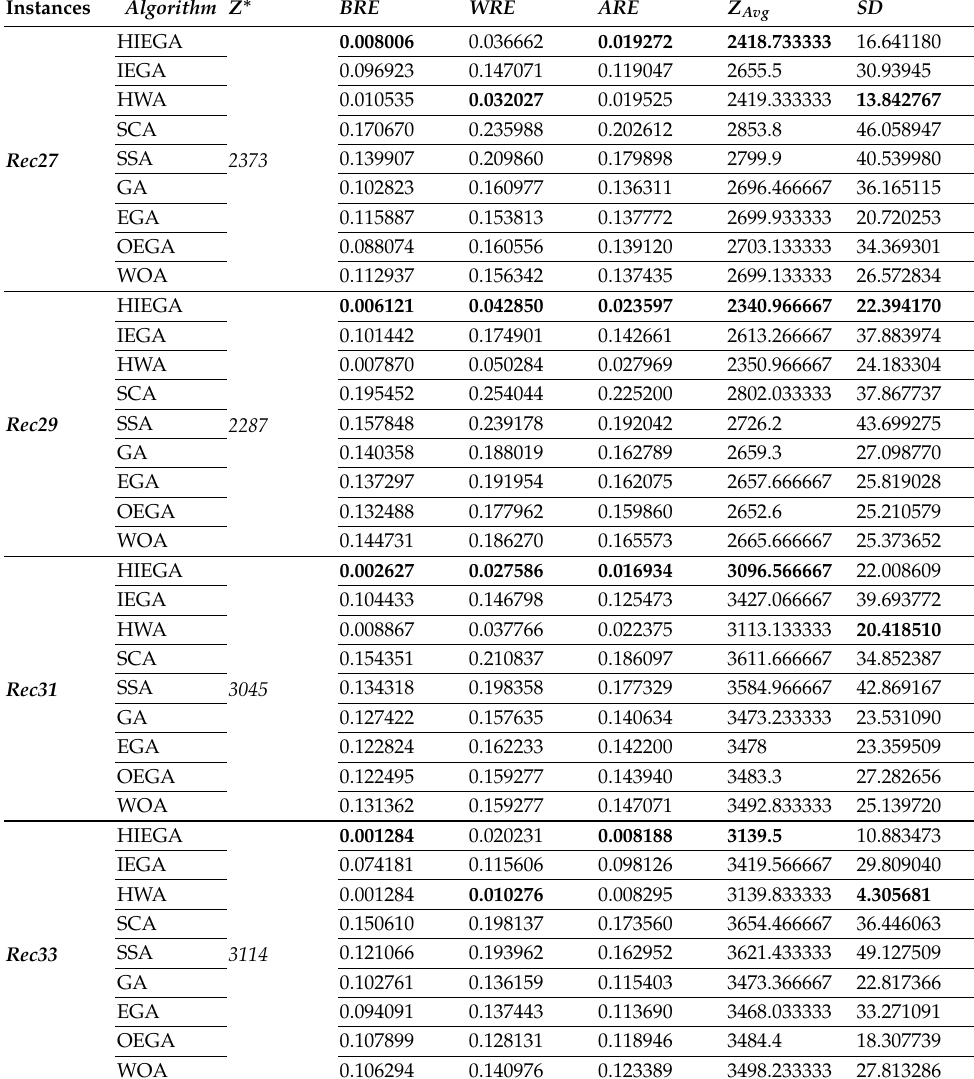
Table 7. Outcomes of different performance metrics on the Reeve instances